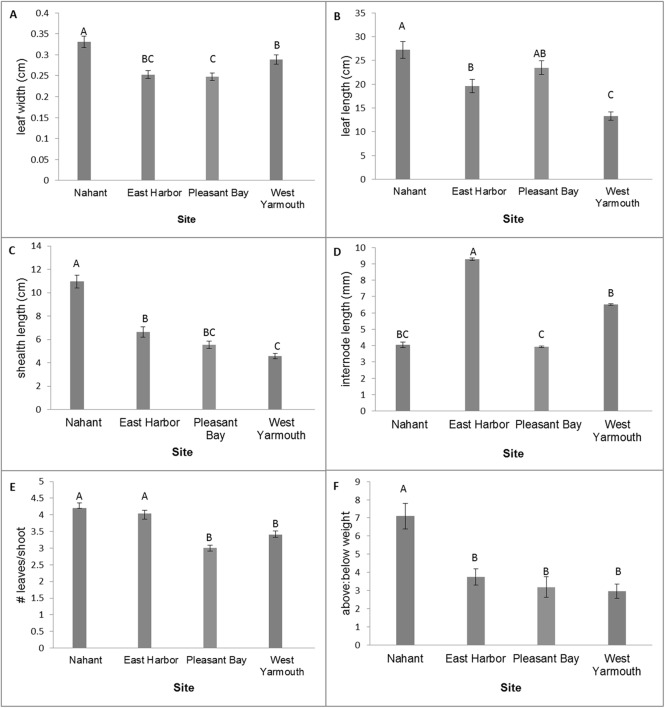
Differences in shoot morphology among the four source populations at start of field experiment.Significant differences were observed among source populations at p < 0.05 (mean ± SE); n = 25; Tukey’s results denoted by letters (A, B, C).